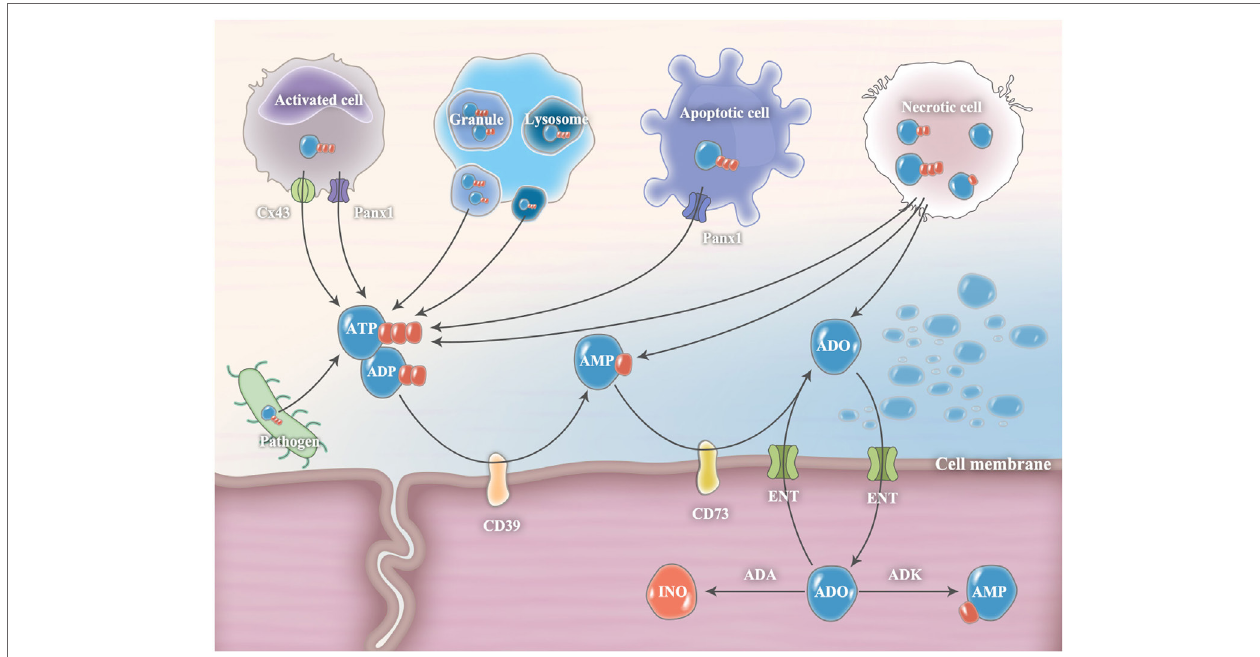
FigURe 1 | Release and metabolism of extracellular ATP and ADO. In pathological conditions, extracellular ATP release is finely controlled by diffusion through connexin 43 (Cx43) or pannexin 1 (Panx1) hemichannels and exocytotic release from ATP-rich vesicles (such as granule and lysosome). During cell apoptosis, Panx1 is cleaved by executioner enzymes of apoptosis (caspase 3 and 7) to generate a truncated and activated subunit that regulates ATP release from apoptotic cells. Under extreme conditions, cellular necrosis will release large amounts of ATP from intracellular storage pools. Pathogenic microorganisms, including bacteria and fungi, are also important sources of extracellular ATP. Extracellular ADP can be released from ADP-rich granules or necrotic cells. In the extracellular milieu, ATP and ADP levels are tightly controlled by plasma membrane ectonucleotidases, CD39 and CD73, which convert ATP/ADP to AMP and subsequently convert AMP to ADO, respectively. The accumulated ADO will be gradually transferred from the extracellular compartment into the intracellular compartment through equilibrative nucleoside transporters (ENTs) and subsequently metabolized to inosine (INO) by adenosine deaminase (ADA) or to AMP by adenosine kinase (ADK).